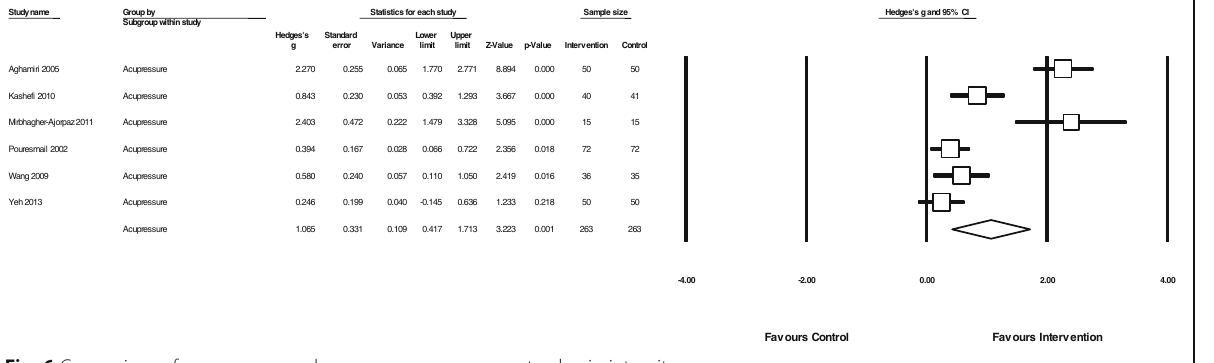
Fig. 6 Comparison of acupressure vs sham acupressure on menstrual pain intensity